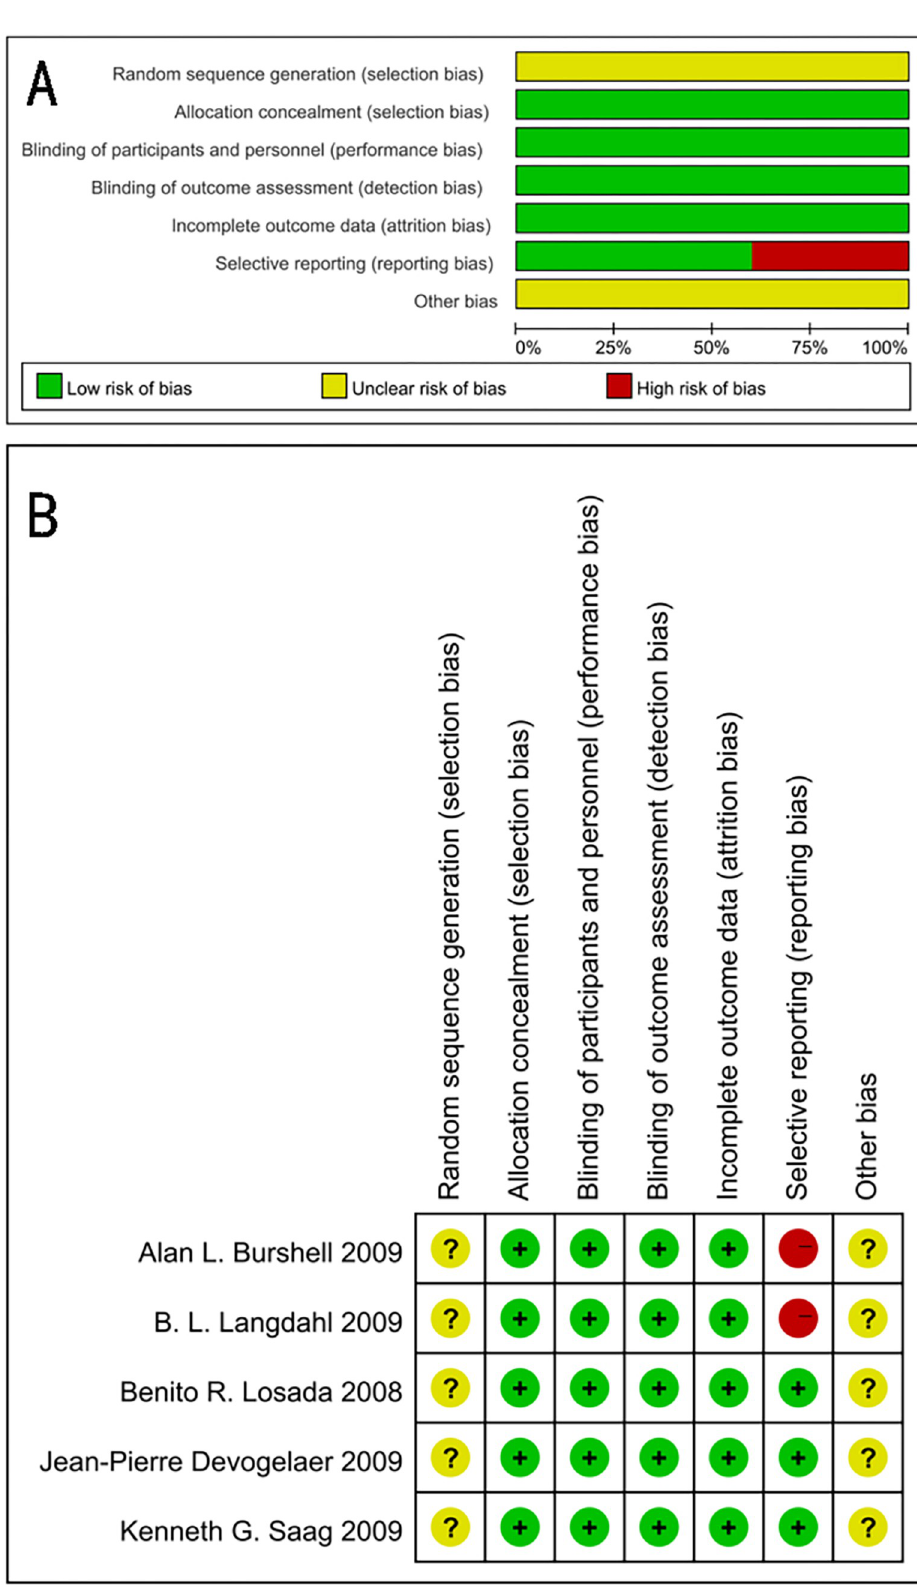
Fig 2. Risk of bias assessment of each included study. (A) Risk of bias graph. (B) Risk of bias summary. https://doi.org/10.1371/journal.pone.0267706.g002 PLOS ONE | https://doi.org/10.1371/journal.pone.0267706 May 31,